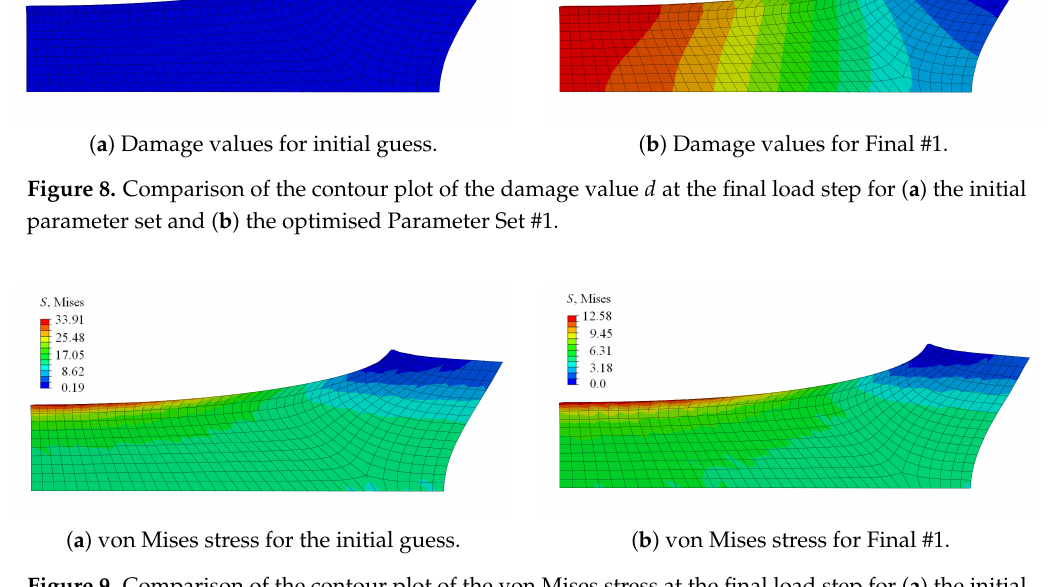
Figure 9. Comparison of the contour plot of the von Mises stress at the final load step for ( a ) the initial parameter set and ( b ) the optimised Parameter Set #1.